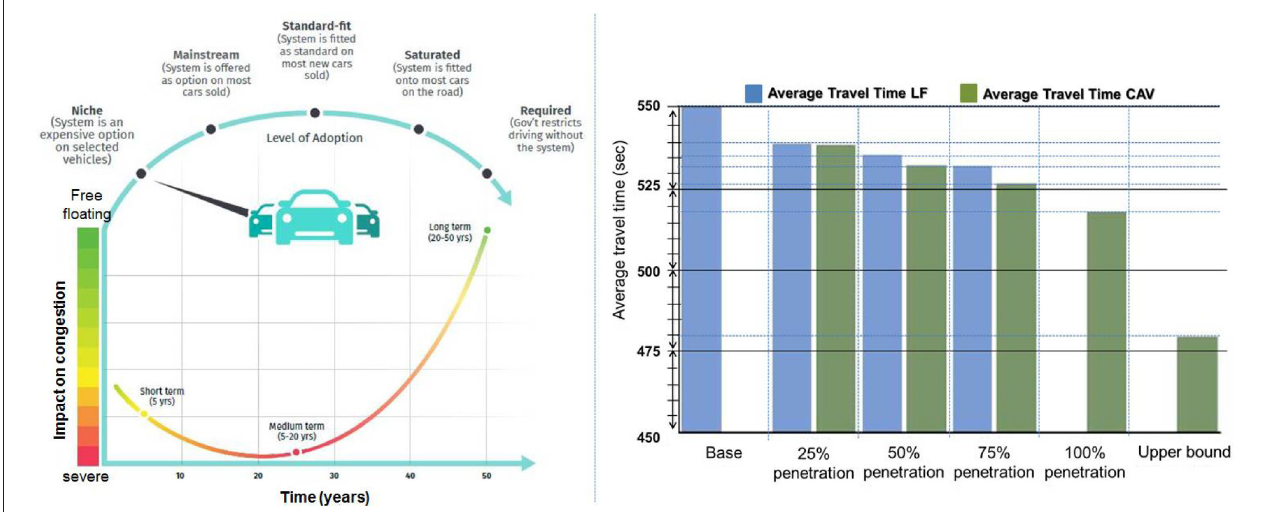
FIGURE 13 | Is CAV deployment an interesting solution in order to optimize traffic? (Left) Impact of CAVs deployment on traffic congestion; (Right) Impact of CAV on travel time saving ( ATKINS,